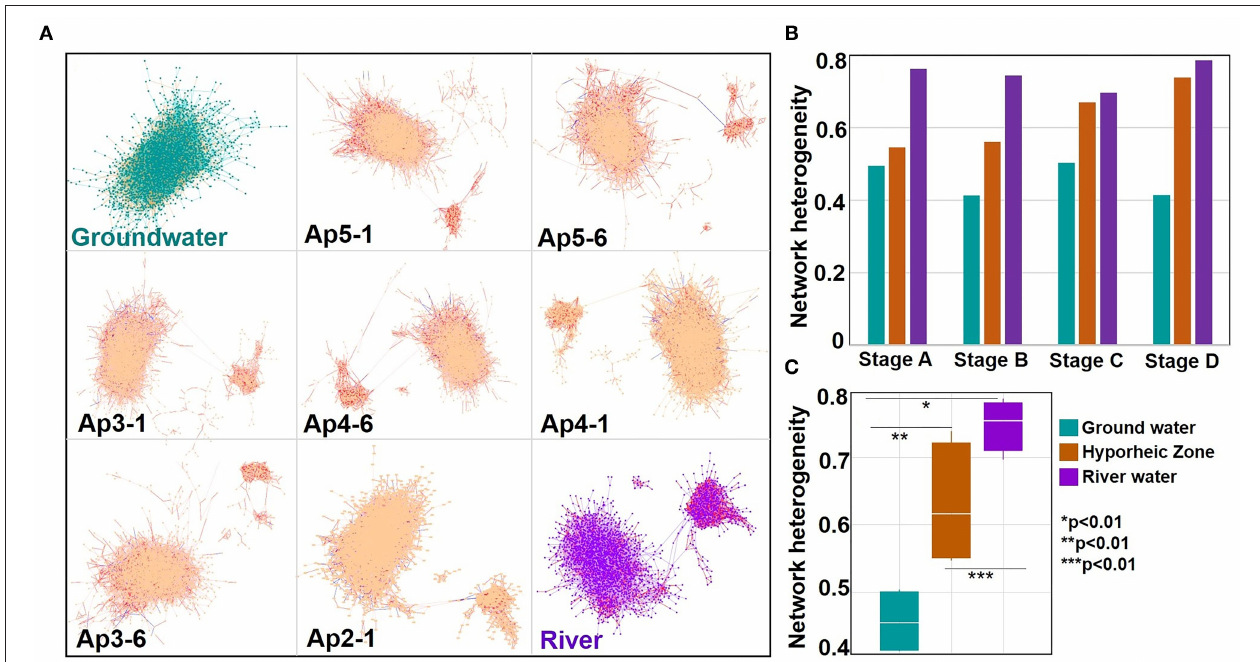
FIGURE 7 | (A) Networks calculated during the network analysis using the full set of chemical transformations (88 transformations) for time interval (river stage) A for each system (ground water, hyporheic zone per piezometer location (where P stands for “piezometer” where as the number next to it refers to the P number. The number after the hyphen refers to the piezometer depth), and river with the system name indicated at the bottom left corner of each panel. Each dot within the figure is an m/z value found within a sample. The lines connecting the m/z values, defined as edges, are chemical transformations. Yellow edges within the ground water network represent the following ground water upregulated transformations (H 2 S, NO − 3 , and PO 3 − 4 , inorganic phosphate, diphosphate, S 2 O 2 − 3 ) intervals. Red edges within the river and hyporheic network represent the following river upregulated transformations (carboxylation, acetylation, malonyl group, glucose transformation, and glycoxylation). Blue edges within the hyporheic network represent the upregulated 20 amino-acids transformations from Figure 5A . Samples from the Hyporheic Zone are organized in descending order which relates to declining ground water input. Large to small networks in hyporheic and river samples are connected by three types of putative transformations: palmitoylation, lysine addition, and ethyl addition; Bar and box plots of changes in the network heterogeneity index (calculated from the network) (B) as function of four-time intervals for each system and (C) grouped over all river stages respectively (with ANOVA and Tuckey test significance represented